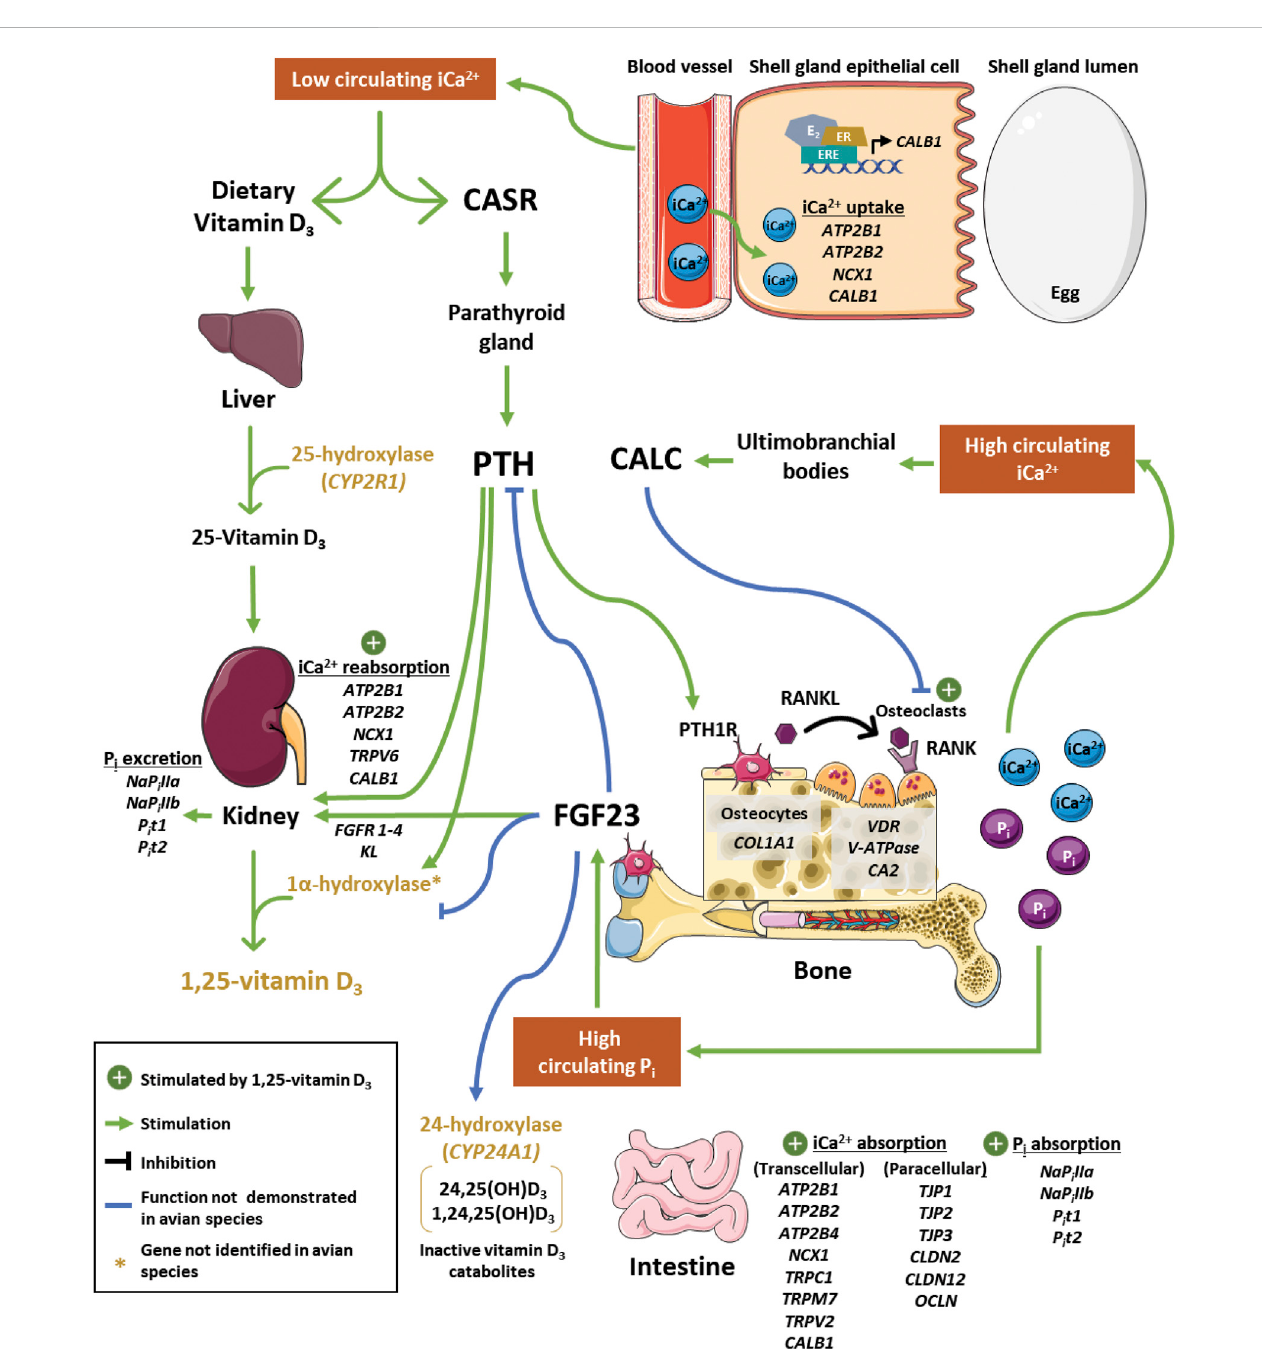
FIGURE 1 Regulationofcalciumandphosphorushomeostasisduringeggshellmineralizationinlayinghens.Duringeggshellcalci fi cation,highdemandforcalcium decreases circulating ionized calcium (iCa 2+ ). Low iCa 2+ is detected by calcium-sensing receptor (CASR), which stimulates parathyroid hormone (PTH) secretion from the parathyroid gland. Secreted PTH binds to PTH receptor 1 (PTH1R) on osteocytes to promote interaction between receptor activator of nuclear factor-kappa B (RANK) and RANK ligand (RANKL) on the osteoclast surface. This induces vacuolar-type adenosine triphosphatase (V-ATPase) production to facilitate bone resorption alongside carbonic anhydrase 2 (CA2). In contrast, bone accretion is facilitated by deposition of matrix proteins such as collagen type 1 alpha 1 (COL1A1). In the kidney, PTH stimulates inorganic phosphate (P i ) excretion and upregulates production of 1,25(OH) 2 D 3 . Bioactive 1,25(OH) 2 D 3 , which binds to vitamin D 3 receptor (VDR), stimulates osteoclast activity, calcium transport in the kidney, and calcium and phosphorus uptake in the intestine. Impacts of 1,25(OH) 2 D 3 in the shell gland and on paracellular intestinal calcium uptake still need to be elucidated. Transcellular transport of calcium in these tissues is thought to occur through ATPase plasma membrane calcium transporting 1, 2, and 4 (ATP2B1, ATB2B2, ATP2B4; intestine only), sodium-calcium exchanger 1 (NCX1), calbindin-28K (CALB1), transient receptor potential cation channels subfamily C member 1 (TRPC1; intestine only), transient receptor potential cation channels subfamily M member 7 (TRPM7; intestine only), and transient receptor potential cation channel subfamily V member two and six (TRPV2, intestine only; TRPV6, kidney only). Paracellular transport in the intestine is achieved by tight junction proteins 1, 2, and 3 (TJP1, TJP2, TJP3), claudin 2 and 12 (CLDN2, CLDN12) and occludin (OCLN). Transport of phosphorus in these tissues is thought to occur by sodium-dependent phosphorus transportersIIa and IIb(NaP i IIa and NaP i IIb)and sodium-dependent inorganic phosphorus transporters1 and2 (P i t1 and P i t2).Shell gland calcium transport by CALB1 may be under the control of estradiol (E 2 ) through estrogen receptor (ER) interaction with estrogen-response elements (EREs) in its promoter region. Bone breakdown releases P i into circulation, which induces production of fi broblast growth factor 23 (FGF23). In chickens and